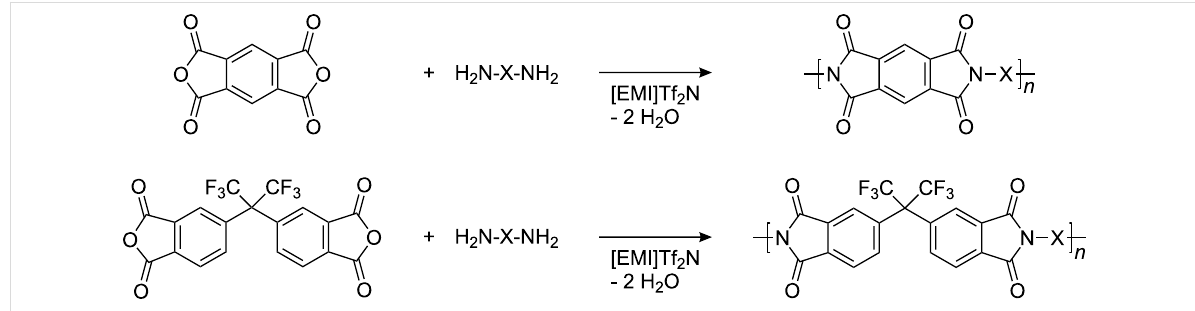
Scheme 2: Polyimide from the reaction performed in the ionic liquid 1-ethyl-3-methylimidazolium bis(trifluoromethylsulfonyl)imide [EMI]Tf 2 N between a diamine H 2 N-X-NH 2 and pyromellitic acid dianhydride, and 4,4'-(hexafluoroisopropylidene)diphthalic anhydride (from [15]).